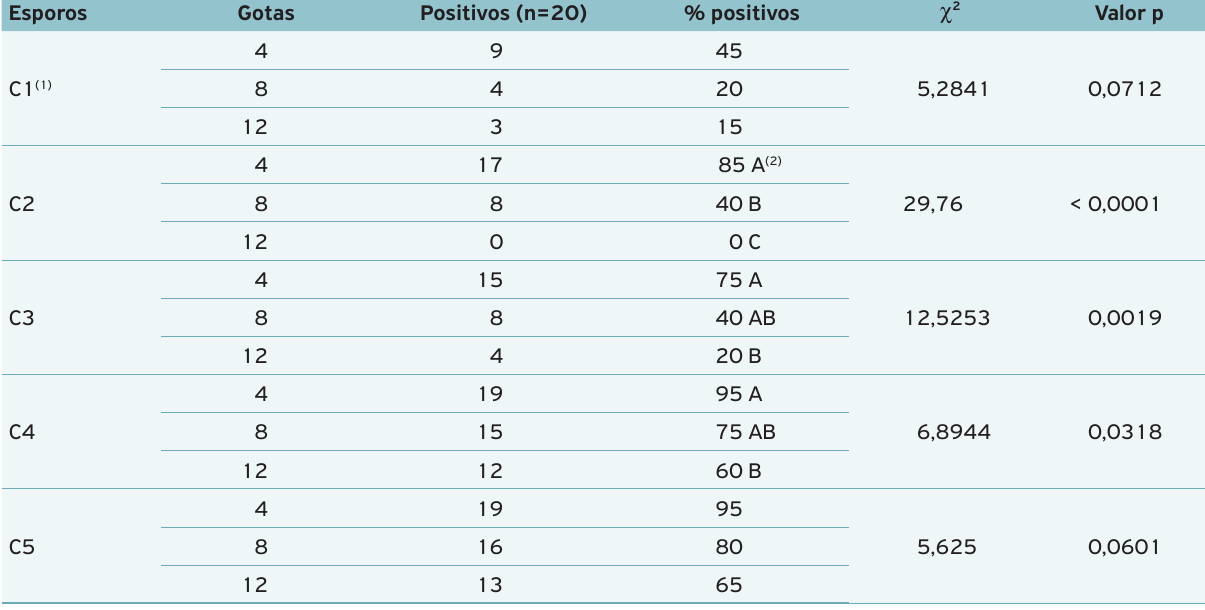
Tabela 1. Comparação entre a proporção de resultados positivos para o número de gotas da solução extratora utilizadas dentro de cada classe de número de